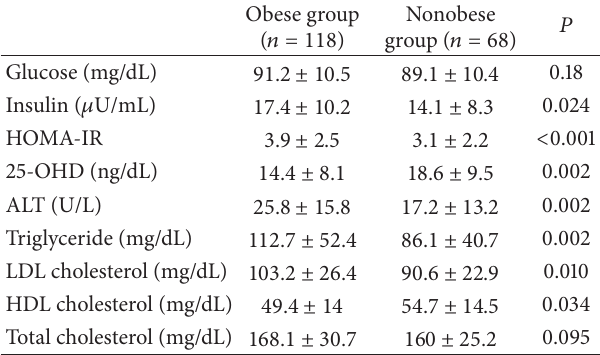
Table 2: Metabolic markers of the study and control